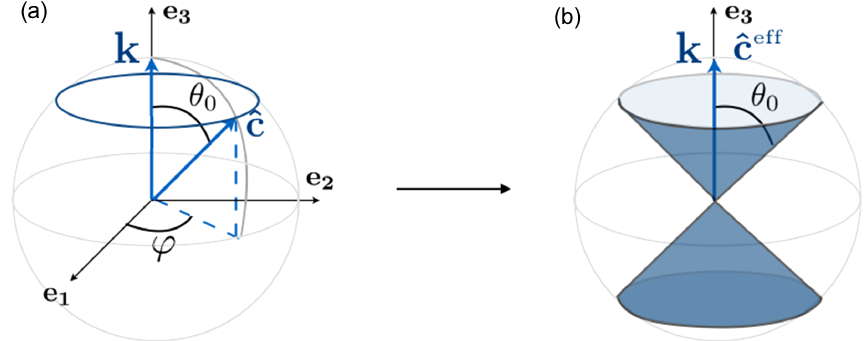
Figure 2. First configuration of a VTI girdle with a single zenith angle θ 0 . (a) shows a typical c axis ˆ c = (sin θ 0 cos ϕ , sin θ 0 sin ϕ , cos θ 0 ) within one grain, with a constant θ 0 , and ϕ varies randomly from grain to grain. (b) shows the resulting VTI texture of the polycrystal at the macroscopic scale. ˆ c eff is the effective c axis.